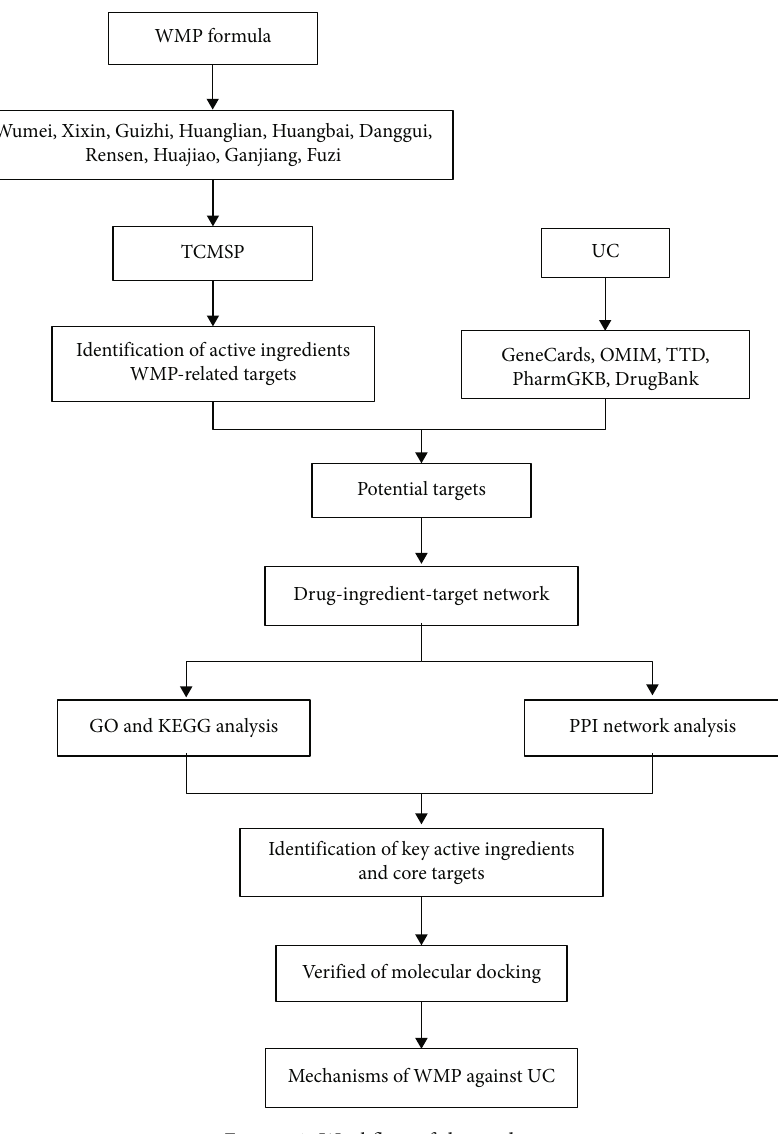
Figure 1: Work fl ow of the